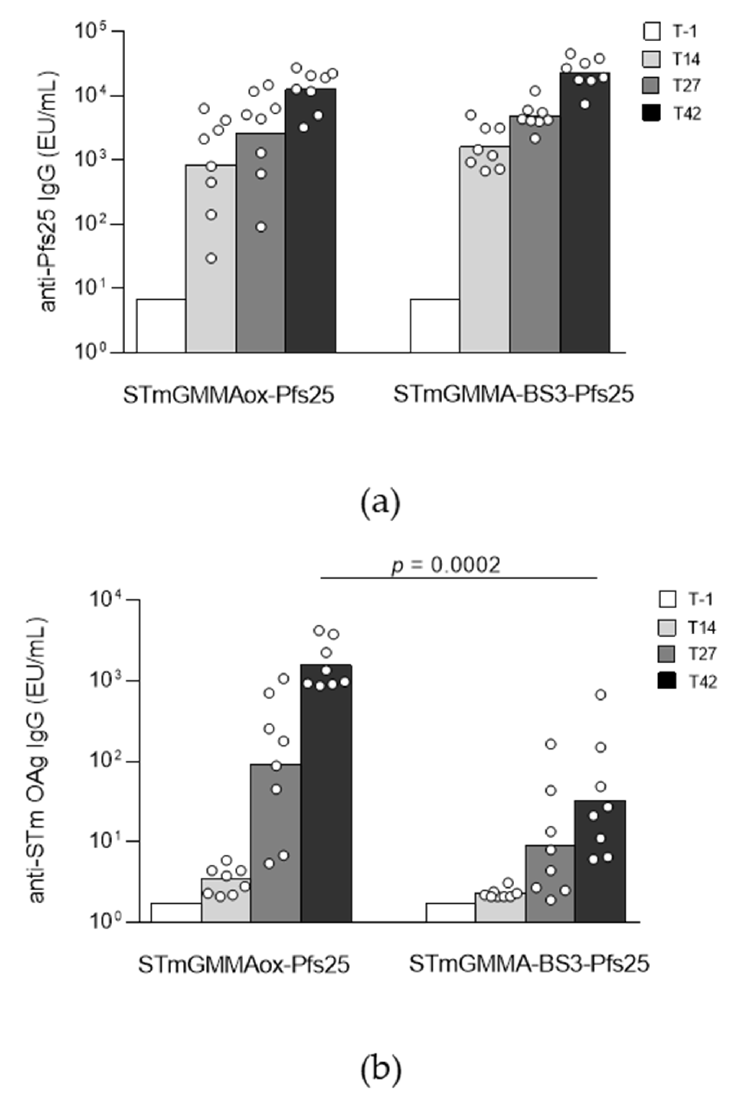
Figure 6. Immunogenicity of Pfs25 GMMA conjugates produced by reductive amination or BS3 chemistry in mice. CD1 mice were immunized subcutaneously at day 0 and 28 with 2.5 µ g total protein dose. All constructs were formulated with 0.7 mg/mL Alhydrogel. Sera were analyzed at days − 1, 14, 27 and 42 by ELISA using as coating antigens Pfs25 ( a ) or STm OAg ( b ). Summary graphs of anti-antigen specific IgG geometric mean units (bars) and individual antibody levels (dots) are